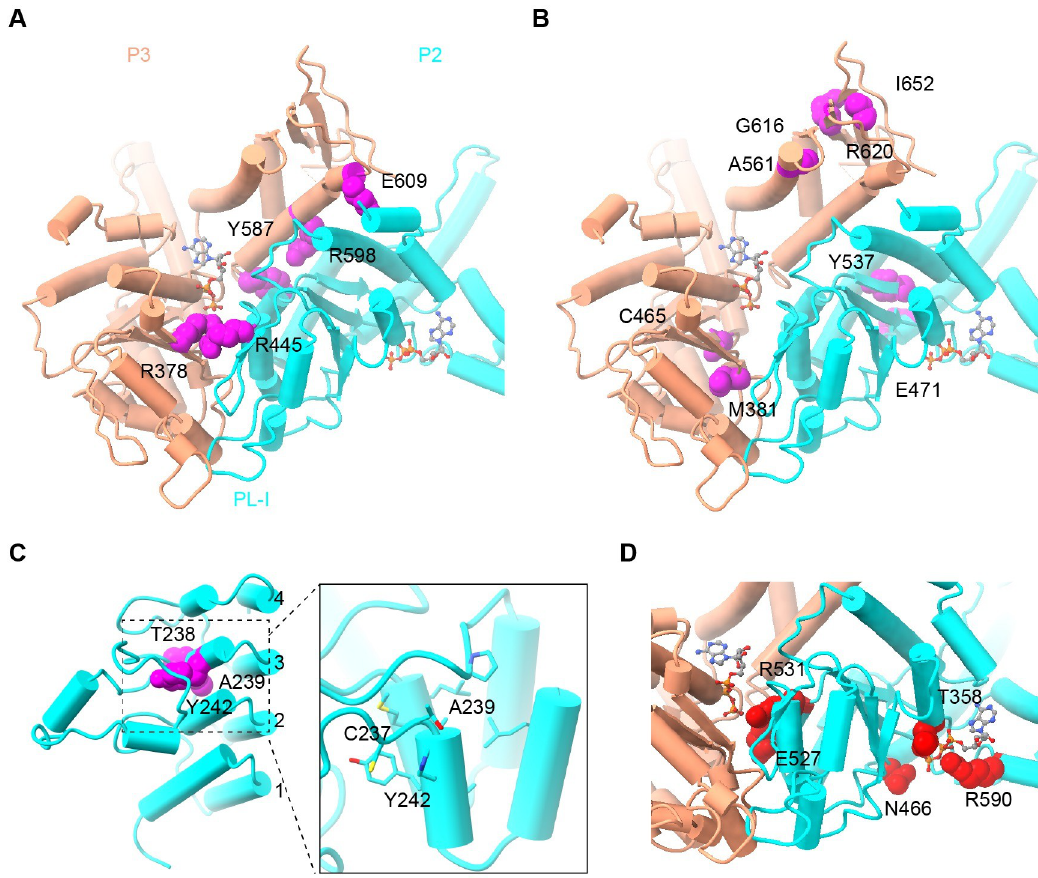
Fig 7. The disease-related mutations of CLPB in 3-MGA and SCN. ( A ) 3-MGA-related mutations in the interface of adjacent protomers. ( B ) 3-MGA-related mutations within the large and small subdomain of the ATPase domain. ( C ) 3-MGA-related mutations in the ANK domain. ( D ) SCN-related mutations in the ATP-binding pocket. Residues on the positions of these mutations are highlighted in magenta or red sphere models. ATP molecule is highlighted in stick models. SCN, severe congenital neutropenia; 3-MGA, 3-methylglutaconic